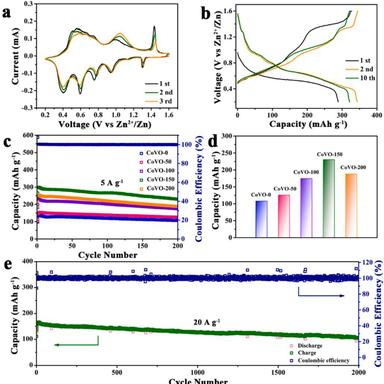
(a) CV curves of CoVO-150 at 0.1 mV s − 1 , (b) discharge/charge profiles at 1 A g− 1 of CoVO-150, (c) cycling performance at 5 A g− 1 of various samples, (d) performance comparison of various samples after 200 cycles, (e) long-term cycling performance of CoVO-150 at 20 A g− 1 .